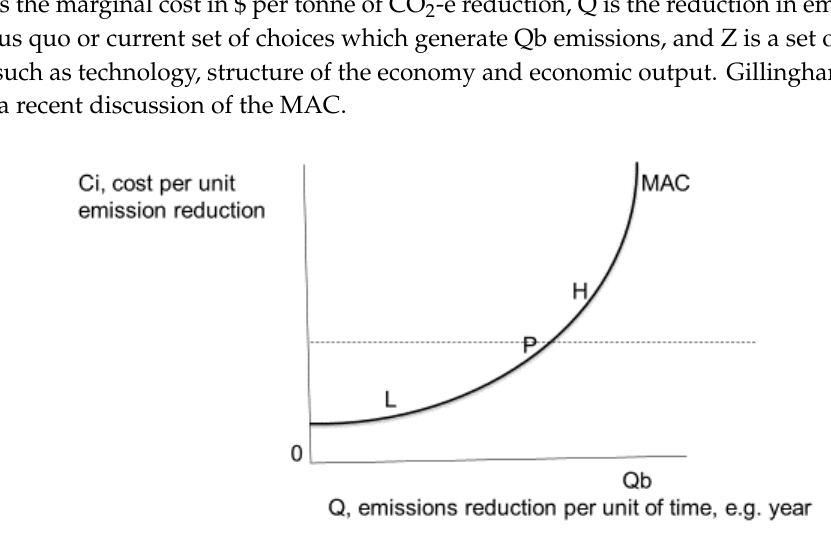
Figure 1. Marginal abatement cost function (MAC).